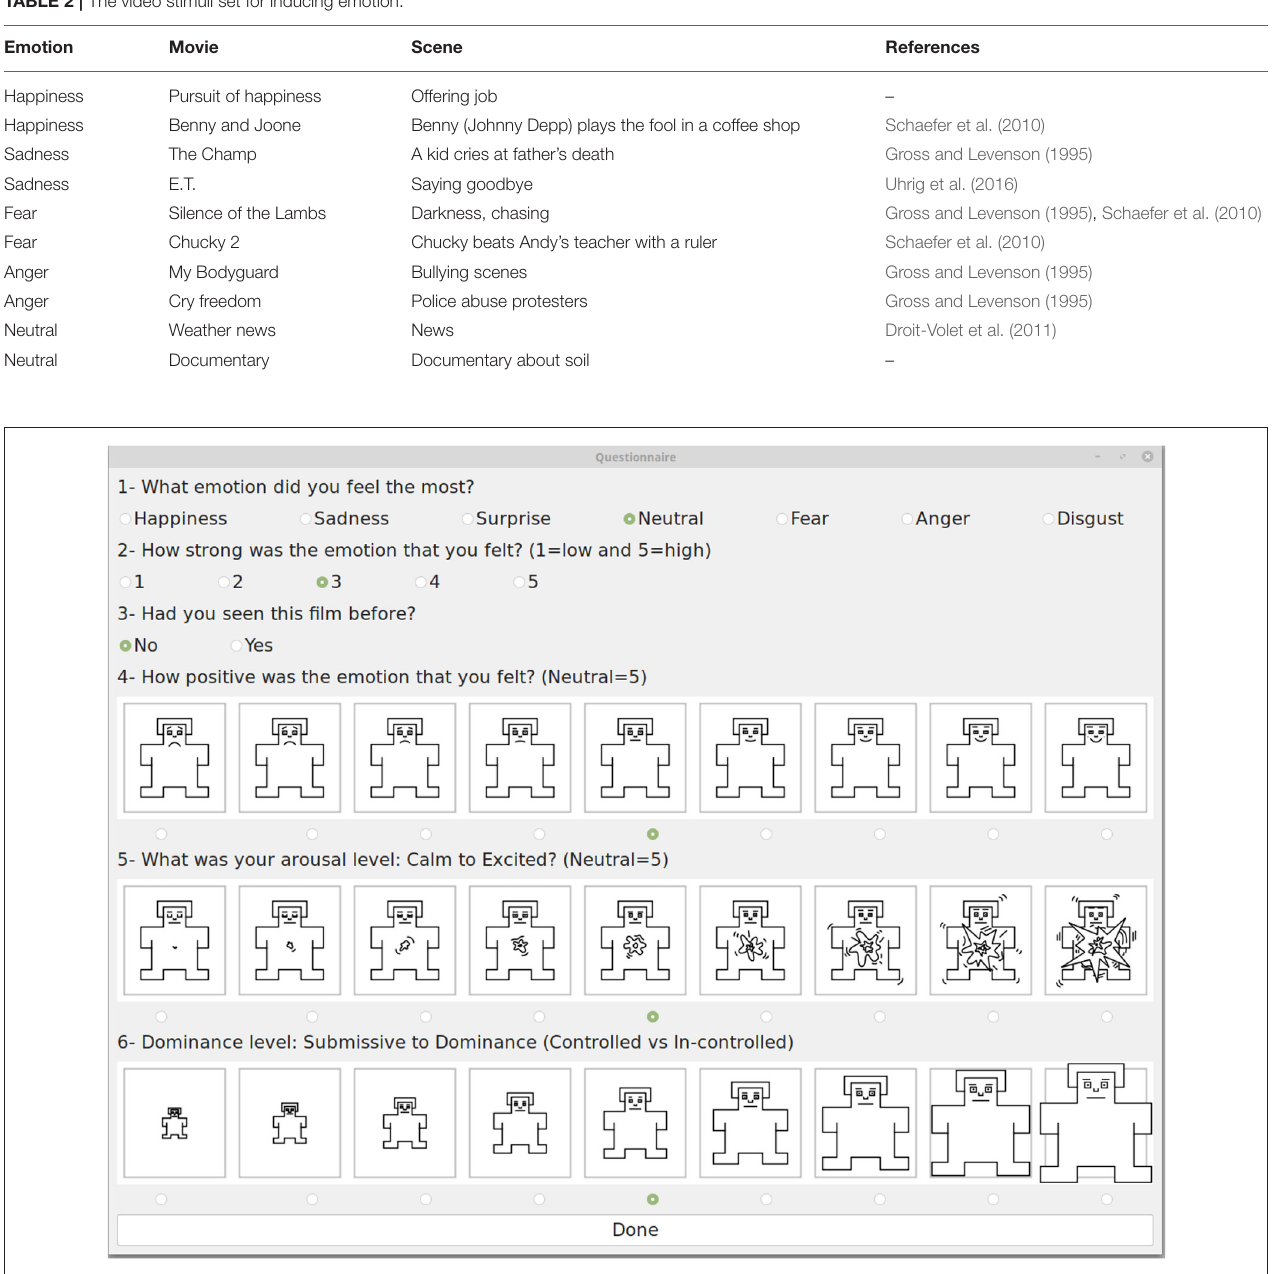
TABLE 2 | The video stimuli set for inducing emotion.